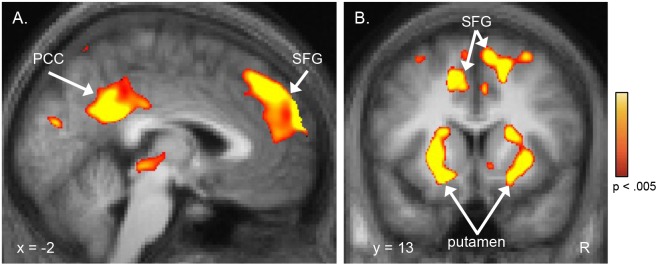
Perfusion of a distributed network of regions outside of the amygdala is also correlated with anxiety levels.A voxel-wise whole brain regression analysis revealed that, in addition to the basolateral amygdala (BLA), perfusion of the superior frontal gyri and posterior cingulate cortex (A), and anterior putamen (B), among other regions (see Table 2), were significantly correlated with anxiety levels. Whole-brain corrected results (see Methods) are displayed here using a voxel-level threshold of p<.005. Clusters that showed cluster-wise significance (p<.05, whole brain corrected) are reported in the text and in Table 2. R, right; PCC, posterior cingulate cortex; SFG, superior frontal gyri.